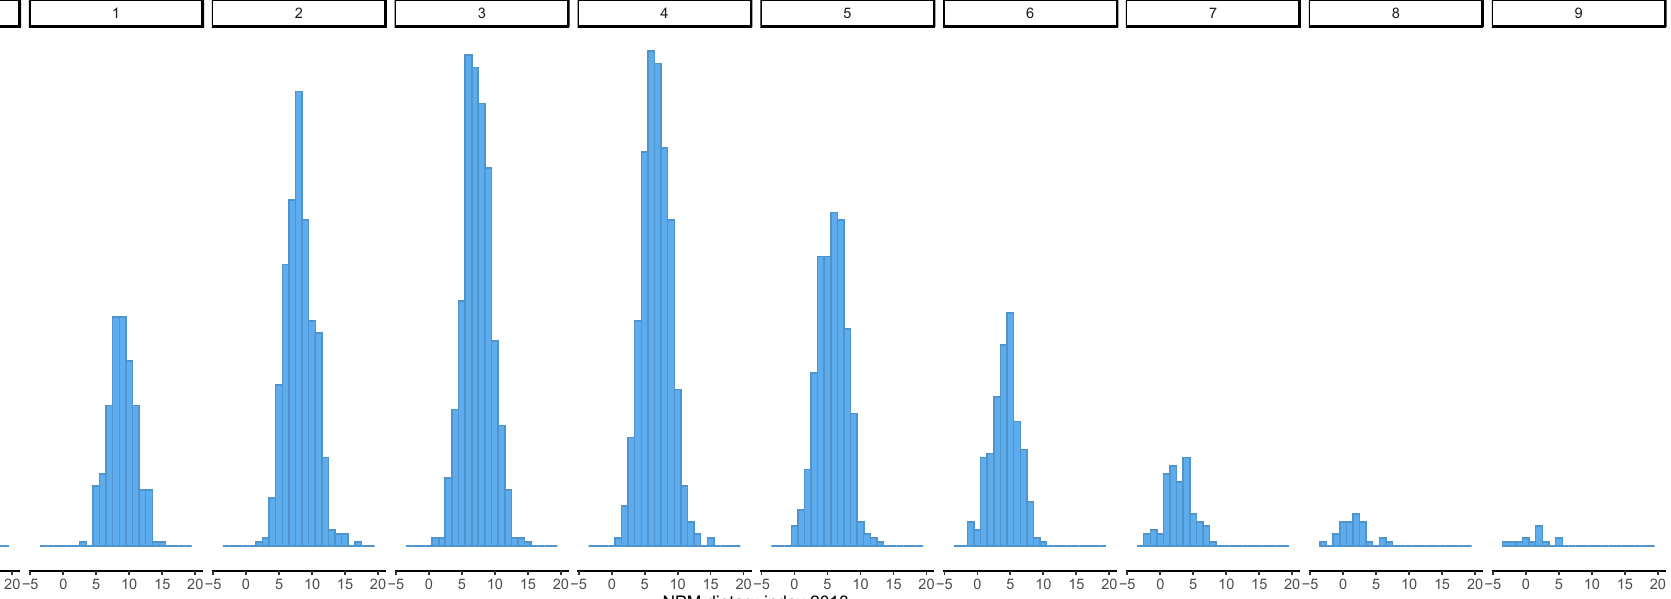
Figure 4. Distribution of the NPM dietary index 2018 by the number of recommendations underpinning the EWG achieved. The NPM dietary index was calculated as the weighted average of NPM for all foods included in each individual’s diet. The EWG score was calculated as the total number of recommendations underpinning the EWG that were met by each individual’s diet. The distribution of the NPM dietary index calculated for individual diets was plotted stratified by level of the EWG score (0– 9). EWG, Eatwell Guide; NPM, nutrient profiling model.